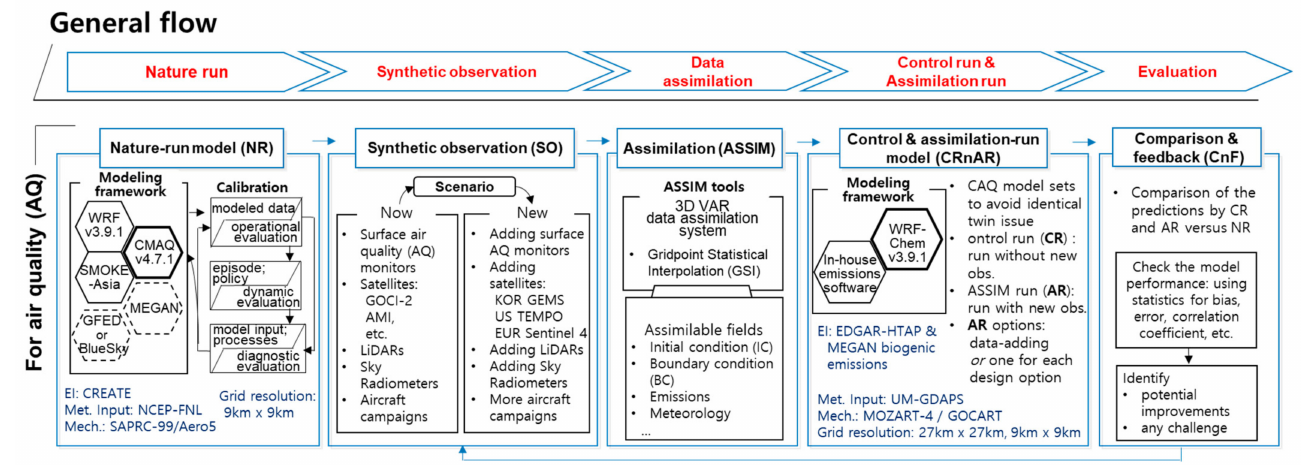
Figure 1. The schematic for the OSSE framework developed in the